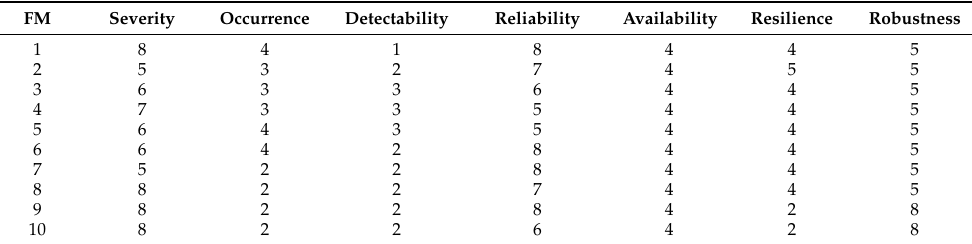
Table 6. Fitting corrosion repair project—risk and performance ratings using a 10-point